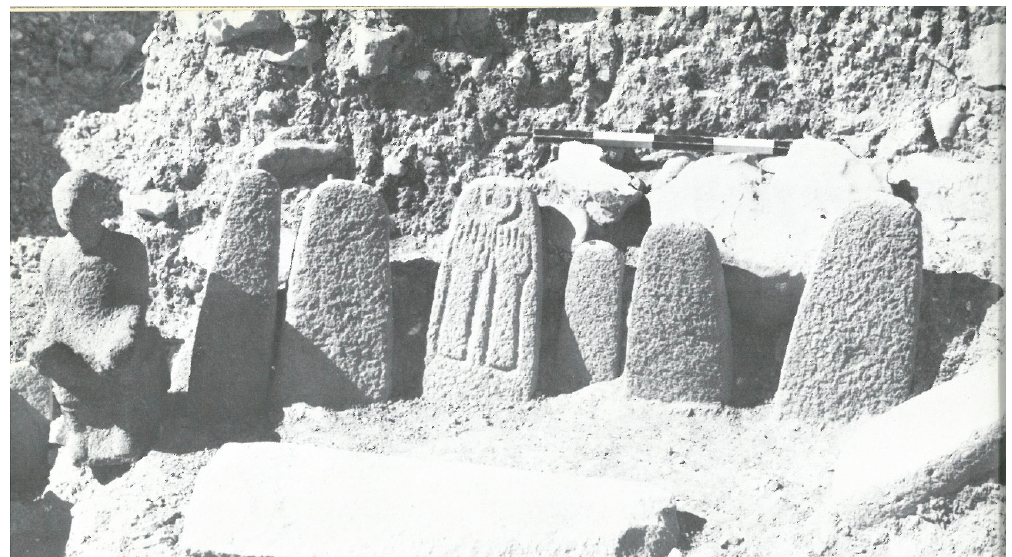
Figure 6. Cultic objects from the “Stelae Temple” in Area C at Hazor (From Yadin 1975: Page 46; courtesy of Amnon Ben-Tor and the Israel Exploration Society).